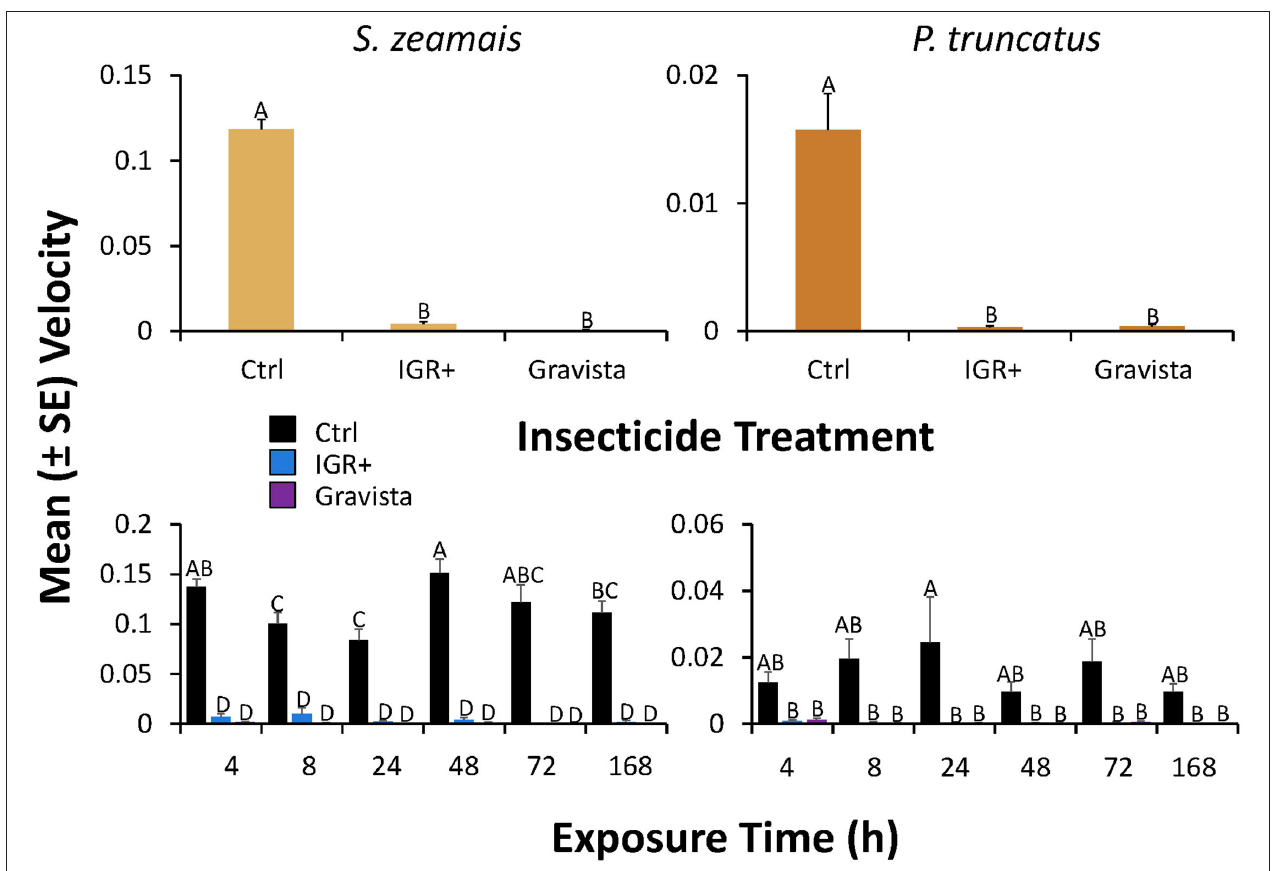
FIGURE 8 | Velocity ( ± SE) by S. zeamais (left column) and P. truncatus (right column) after application of an existing (methoprene + deltamethrin, IGR + ) and novel (methoprene + deltamethrin + synergist, Gravista) commercial formulation of insecticide to maize as a grain protectant compared to a control overall (top panels) or broken down by exposure time (bottom panels) . Bars with shared letters are not significantly different from each other (Tukey HSD, α =